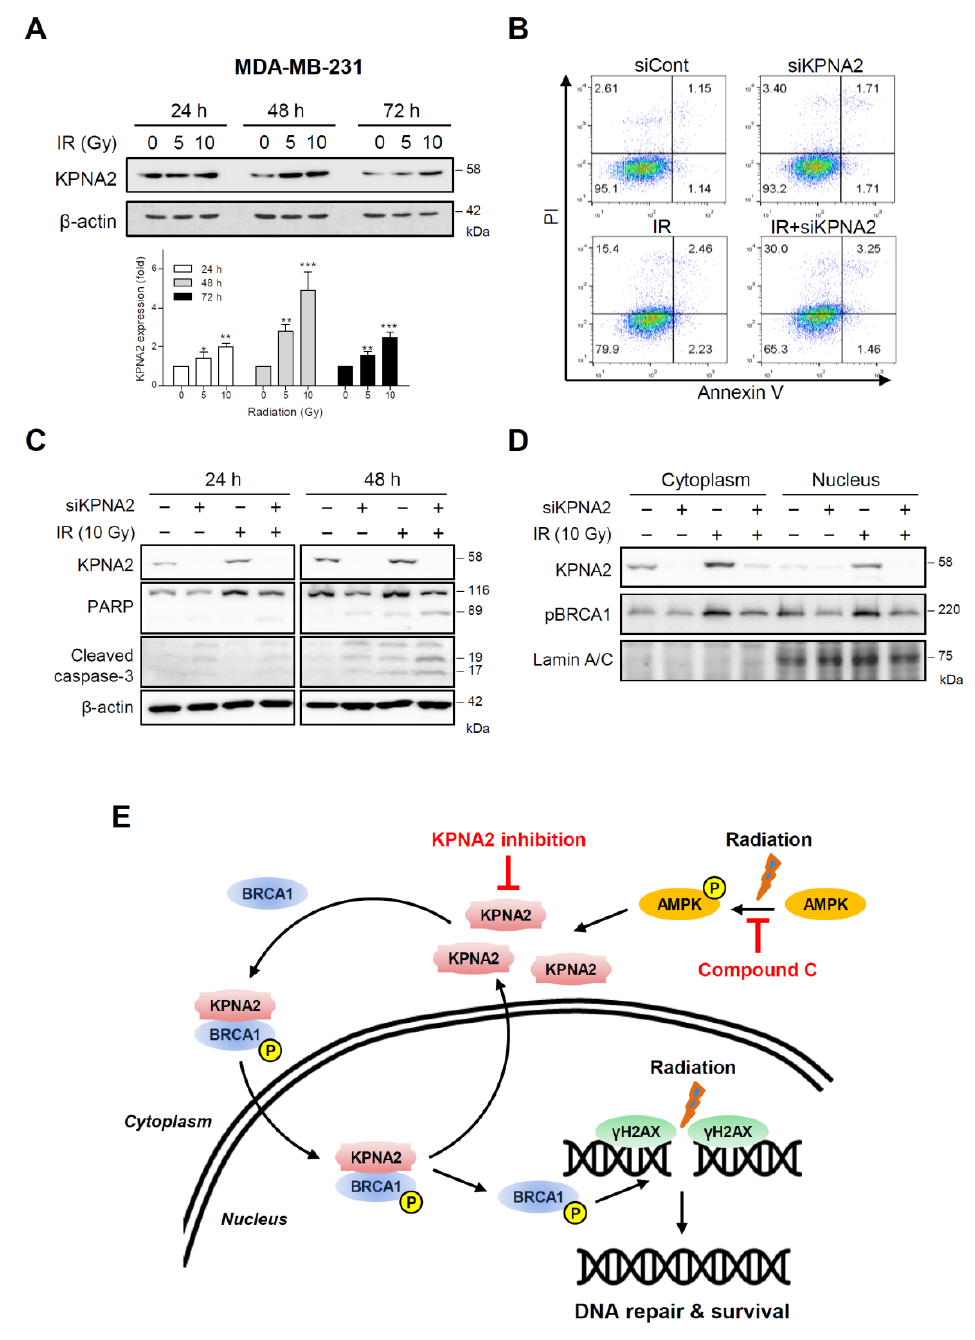
Figure 5. Inhibition of KPNA2 increases radiation-induced cell death in MDA-MB-231 cells. ( A ) MDA-MB-231 cells were lysed at the indicated times after exposure to 5 or 10 Gy of IR and